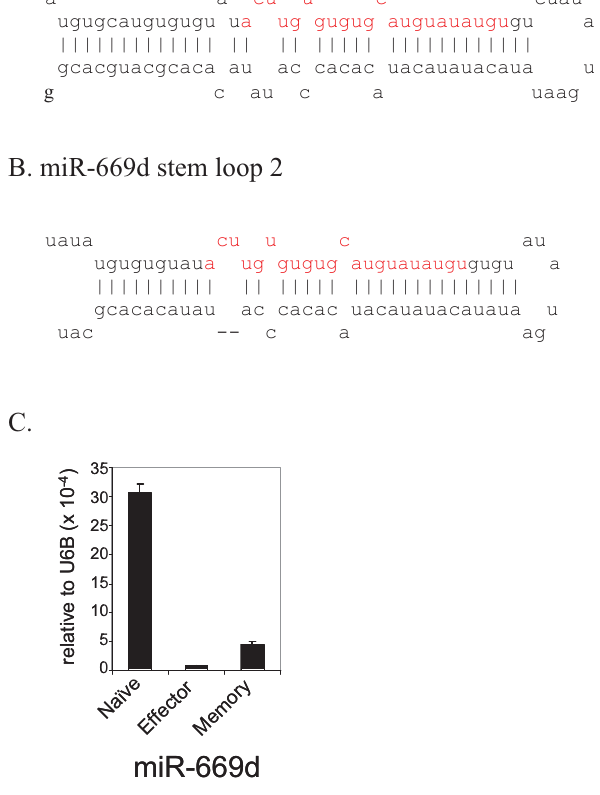
Figure 5. Novel miRNA–miR-669d in mouse T cells. The presence of the stem loop sequences for miRNA-669d in the mouse genome is depicted in (A-B). C) Small RNAs from mouse T cells were tested for the presence of miR-669d by real time RT-PCR. Expression level was normalized to that of small non-coding RNA U6B. Mean of triplicate experiments 6 SD is shown.